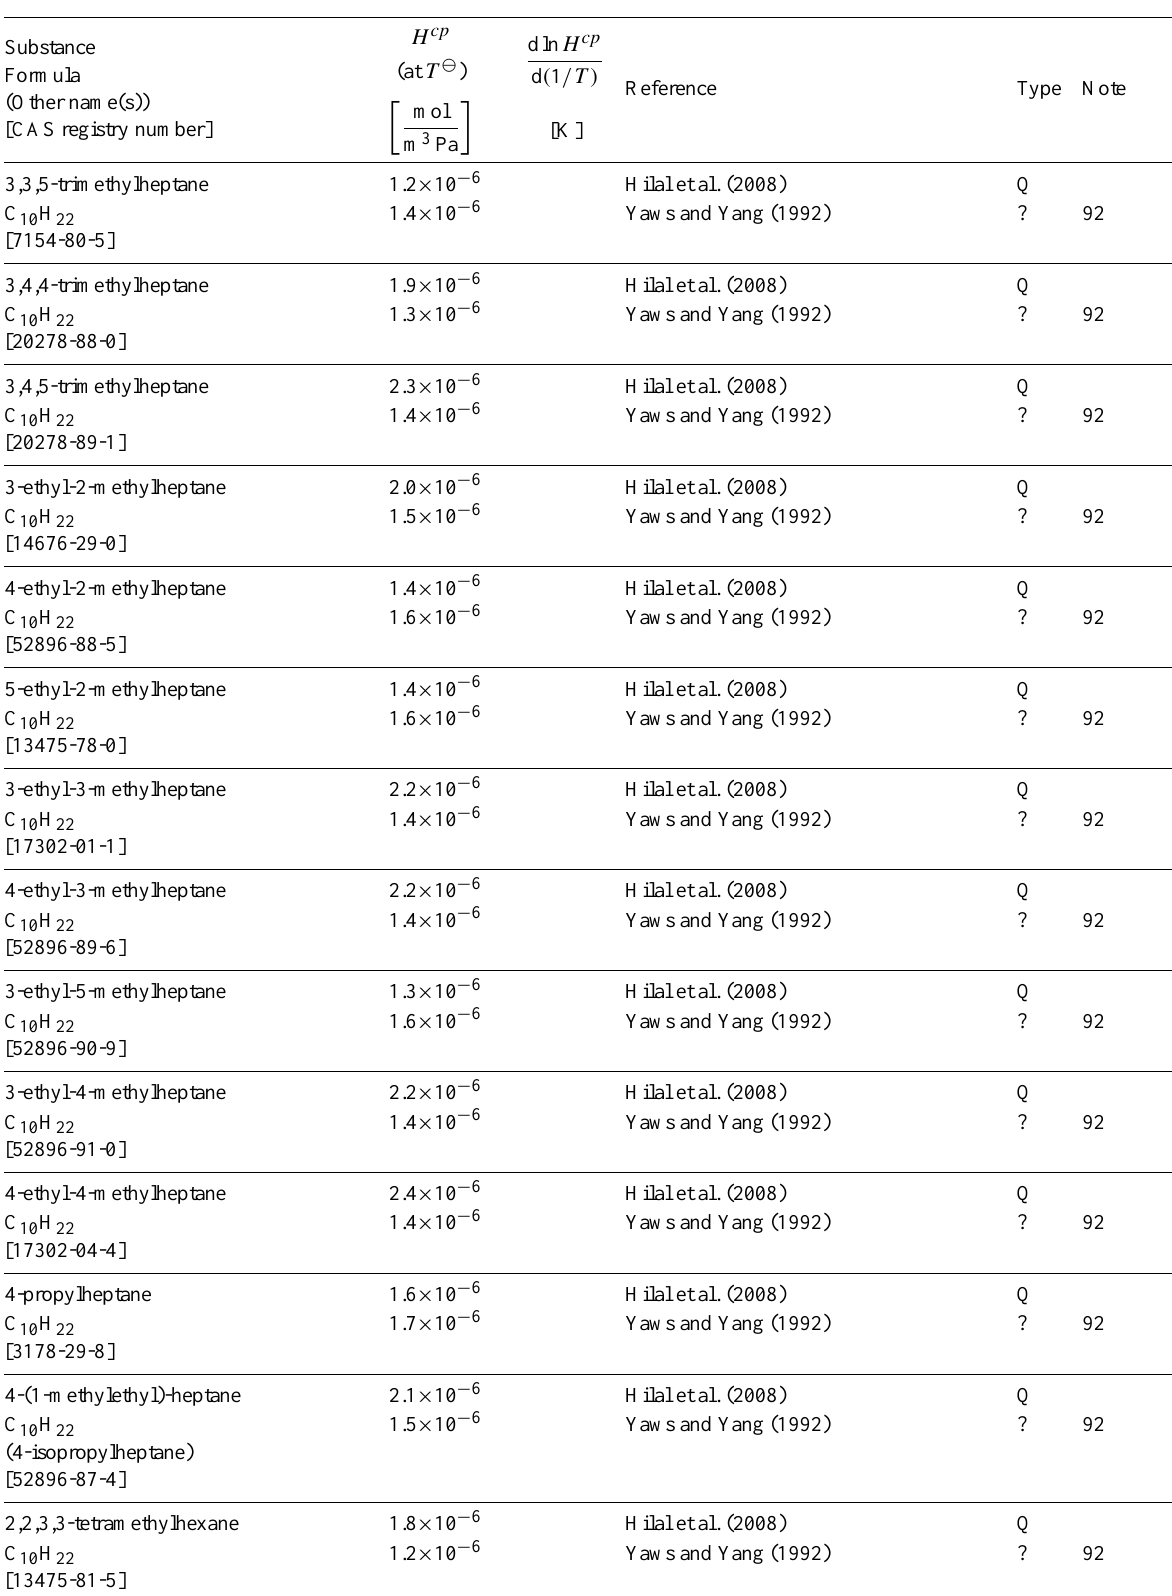
Table 6: Henry’s law constants for water as solvent